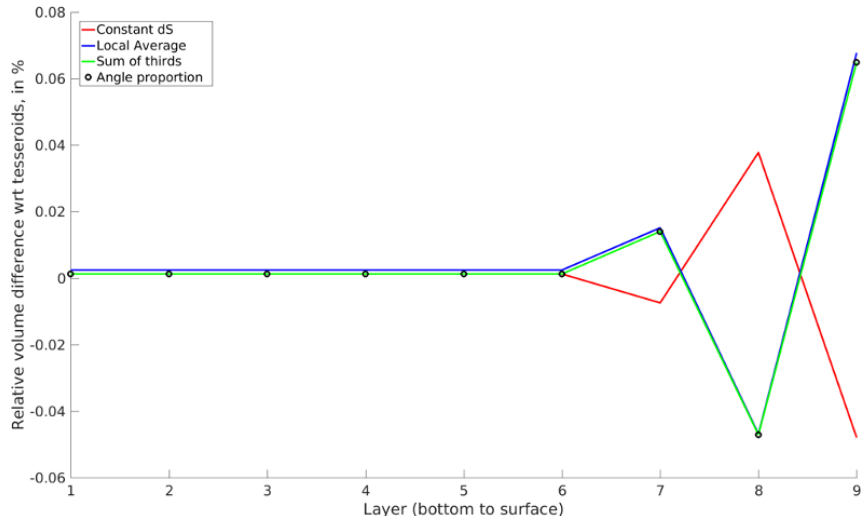
Figure B1. Relative volume differences per layer (from 400km) of WINTERC-G with respect to the tesseroids.